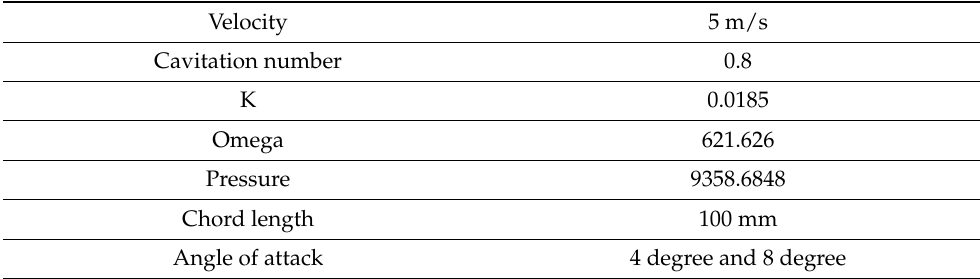
Table 2. Parameters of work